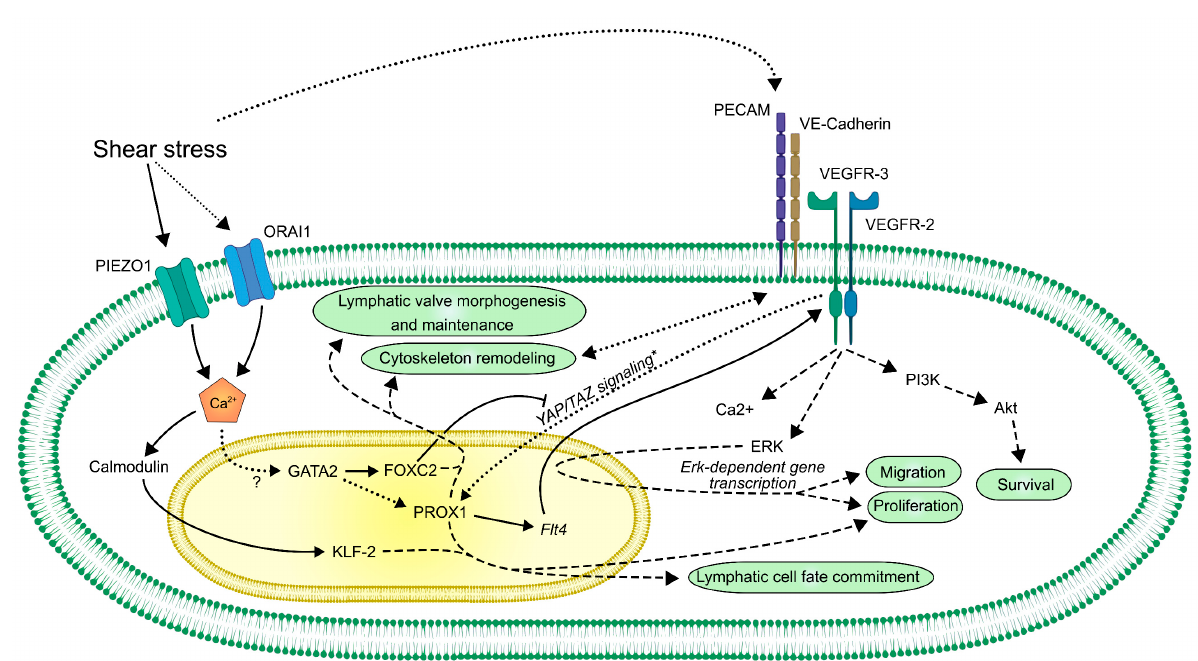
Figure 3. A schematic overview of the currently known mechanosensory and mechanotransduction molecular pathways in LECs. Lines represent direct connections between molecules, such as regulation of transcription, complex formation, direct activation, or inactivation. Dashed lines represent an indirect connection. Dotted lines represent assumed or still unclear connections.